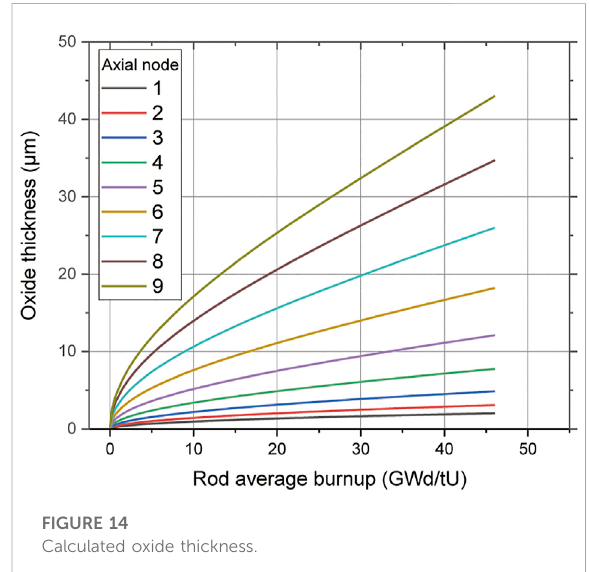
FIGURE 14 Calculated oxide thickness.